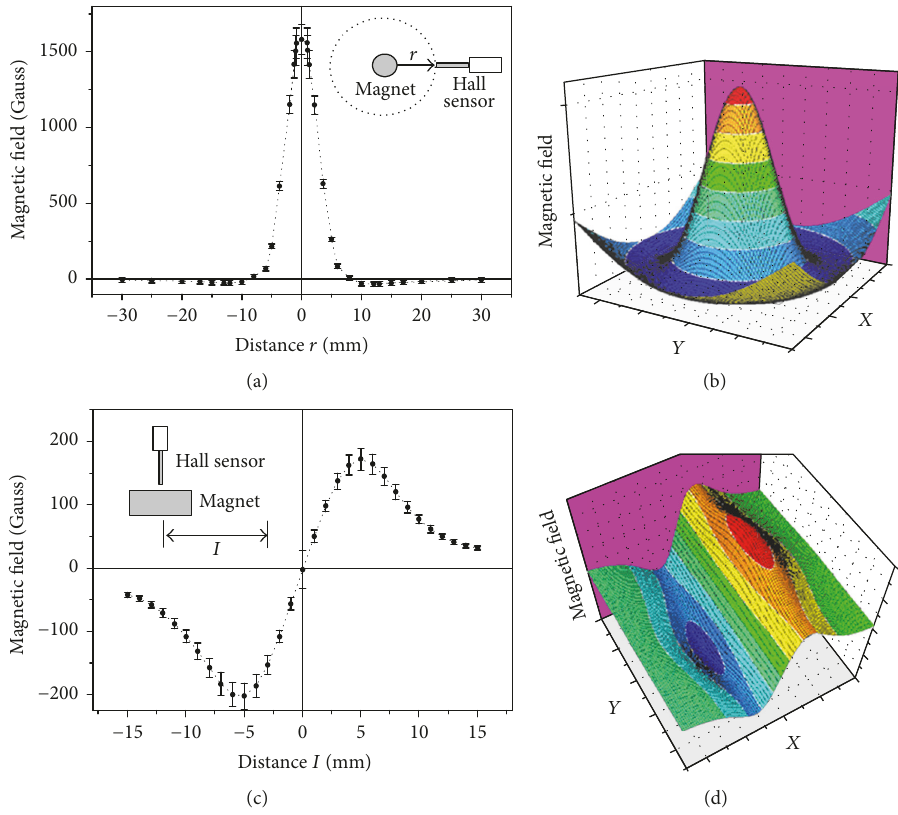
Figure 3: Plots representing the magnetic field using the Gaussmeter. (a) The plot of the magnetic field in the monopolar configuration (also known as unipolar configuration) and (b) the two-dimensional plot of the intensity of the magnetic field. (c) The plot of the magnetic field in the bipolar configuration and (d) the two-dimensional plot of the intensity of the magnetic field. When the magnet is placed at the top of the Ferrocell, the ferrofluid reacts to one of these configurations depending on its